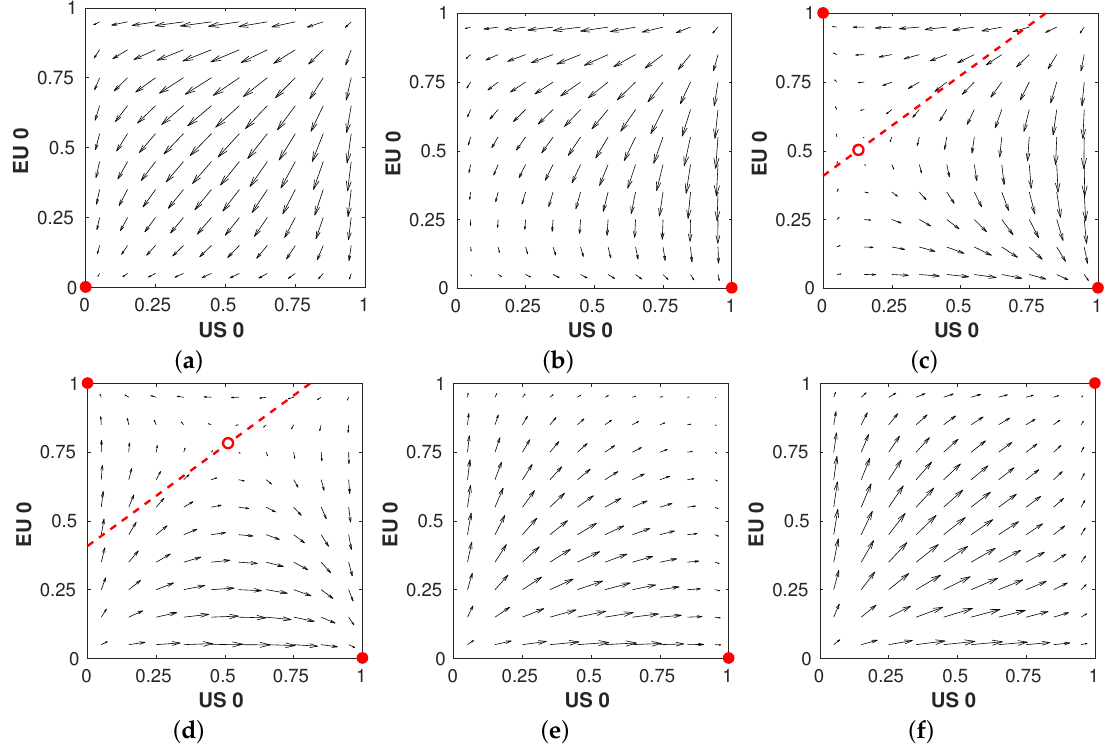
Figure 9. Evolutionary dynamics of the sub-game {remove 0, remove 1} for different values of C r . Stable attractors are indicated with and unstable attractors with . The dotted line indicates the trajectory on which the mixed equilibrium moves as C r changes. ( a ) C r = 0.0024; ( b ) C r = 0.0027; ( c ) C r = 0.00285; ( d ) C r = 0.003; ( e ) C r = 0.00315; ( f ) C r =